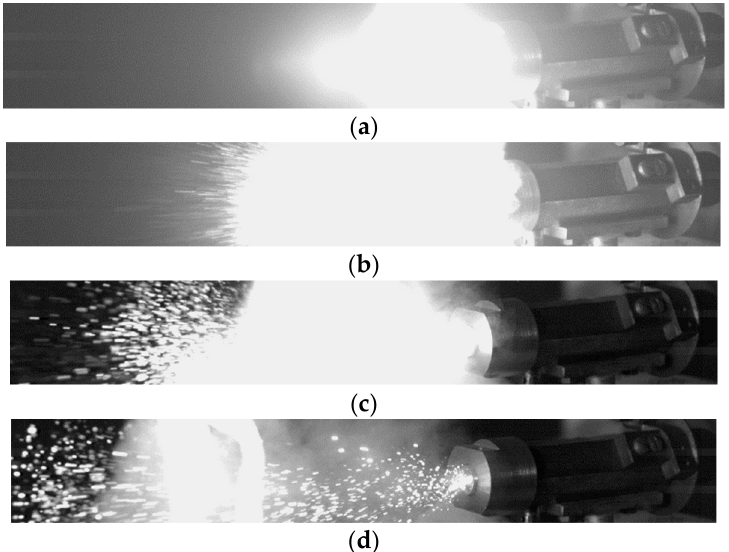
Figure 16. Results of the optical recording of the outflow from the primer into an open space: ( a ) 0.2 ms, ( b ) 0.4 ms, ( c ) 1 ms, ( d ) 2 ms.